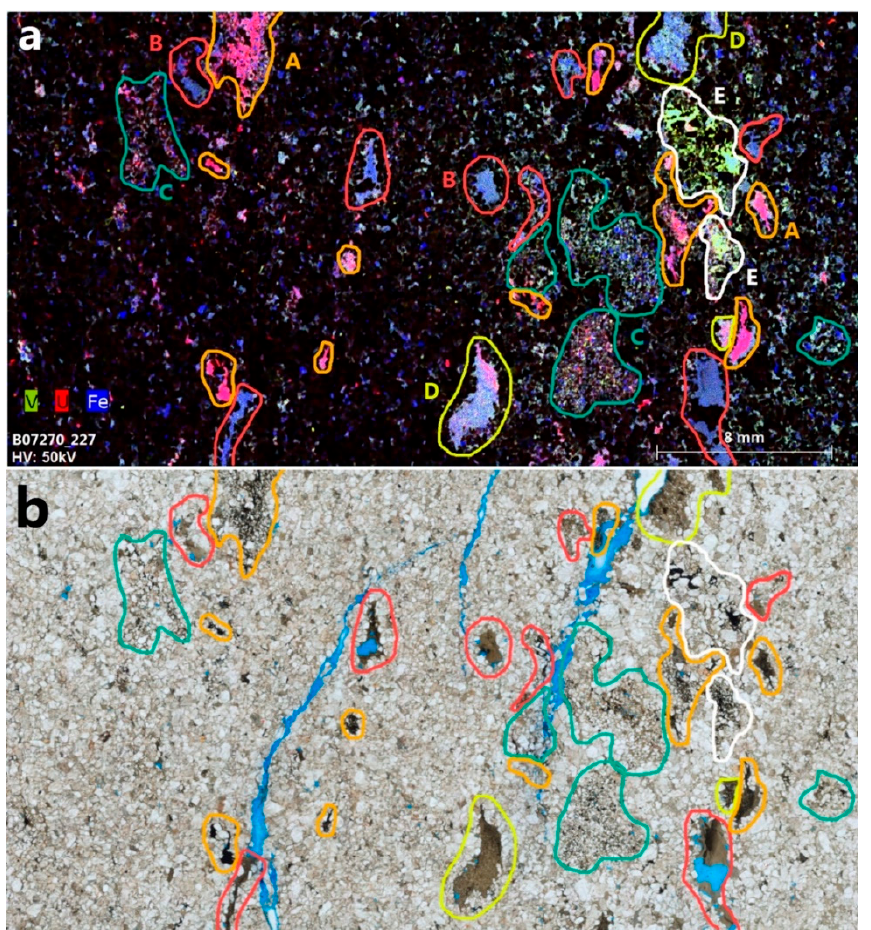
Figure 9. ( a ) XRF elemental image of vanadium-rich core sample B07270—227m (V 2 O 5 0.88%, U 3 O 8 0.07%) categorized by element showing the V-U-Fe characteristics of various kinds of lithic rip-up clasts (mudstone, siltstone and clay-rich matrix-supported sandstone) present in the host sandstone. A (orange): uranium-rich sandstone and mudstone, some chemically zoned; B (red): Fe-rich mudstone; C (green): clay-rich, fine-grained sandstone, weakly mineralized; D (yellow): V-U-Fe enriched siltstone, zoned; E (white): V-clay- and V-oxide-rich sandstone with coarse and fine-grained domains; ( b ) same thin section but imaged under plain light showing the heterogeneous textures of the lithic clasts. Blue-stained areas are holes in the thin section where soft, clay-rich material has fallen out during preparation of the section.